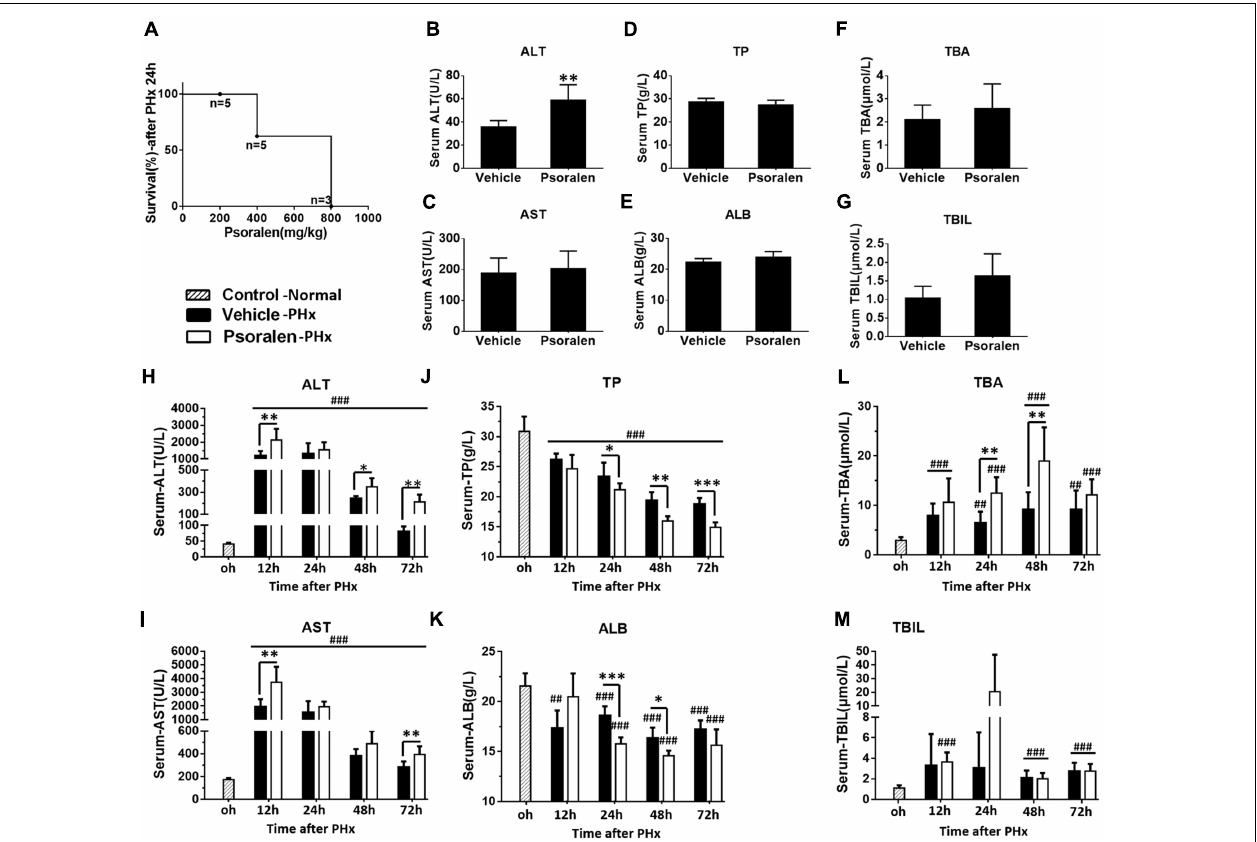
FIGURE 4 | Psoralen toxicity increased and psoralen aggravated acute liver injury in PHx mice. C57BL/6 mice were subjected to PHx. (A) Mortality of PHx mice after 200 mg/kg, 400 mg/kg, or 800 mg/kg psoralen treatment. (B–G) Normal C57BL/6 mice were treated with 200 mg/kg of psoralen or 0.5% CMC-Na for 48 h ( n = 8). (B) Serum ALT, (C) AST, (D) TP, (E) ALB, (F) TBA, (G) TBIL levels were determined. (H–M) C57BL/6 mice were subjected to PHx and treated with 200 mg/kg of psoralen or 0.5% CMC-Na. (H) Serum ALT, (I) AST, (J) TP, (K) ALB, (L) TBA, (M) TBIL levels were determined. Data are means ± SDs ( n = 6–8). ∗ p < 0.05, ∗∗ p < 0.01, ∗∗∗ p < 0.001 versus vehicle group. ## p < 0.01, ### p < 0.001 versus control